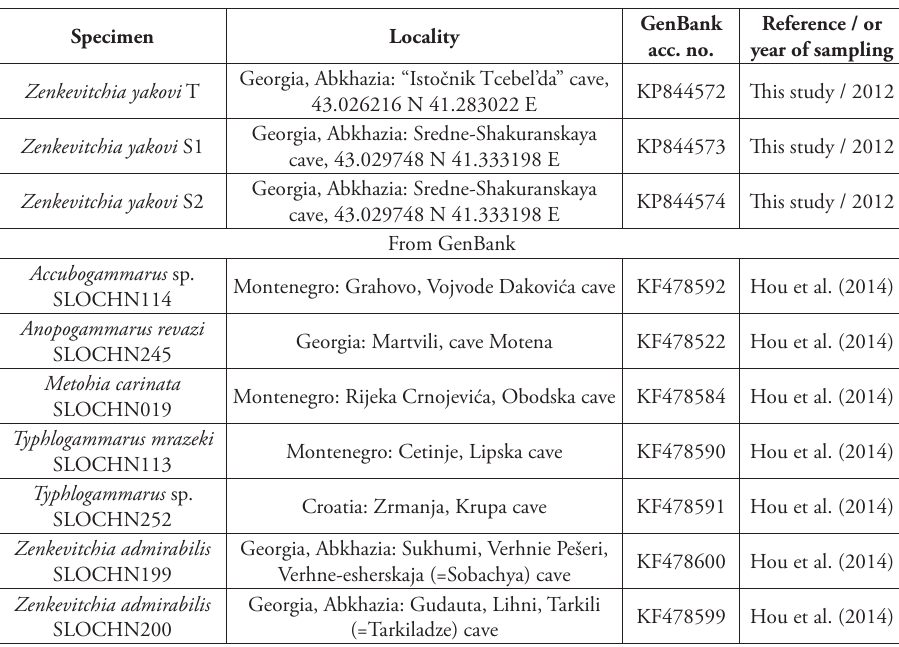
Table 2. List of the specimens, sampling sites and accession numbers of the sequences for COI included in this study. References are given for sequences obtained from GenBank.